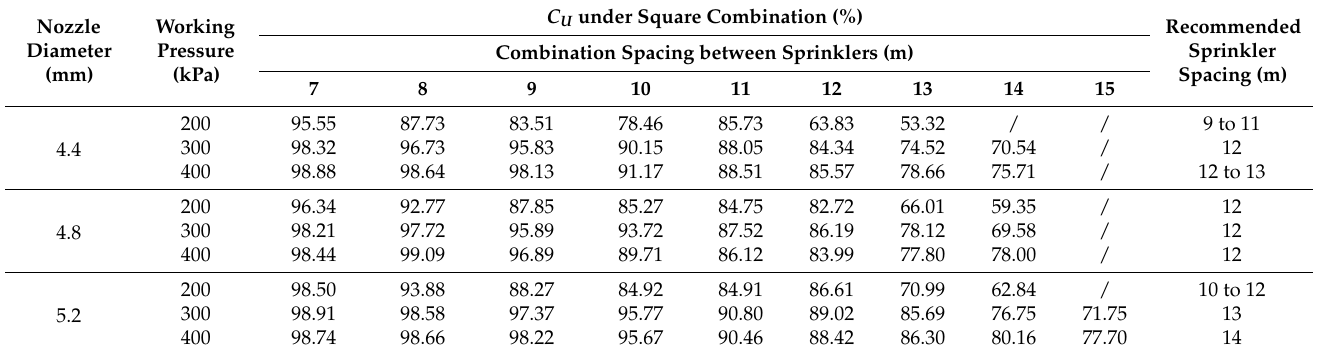
Table 4. Christiansen uniformity coefficient ( C U ) of combined sprinkler irrigation under square